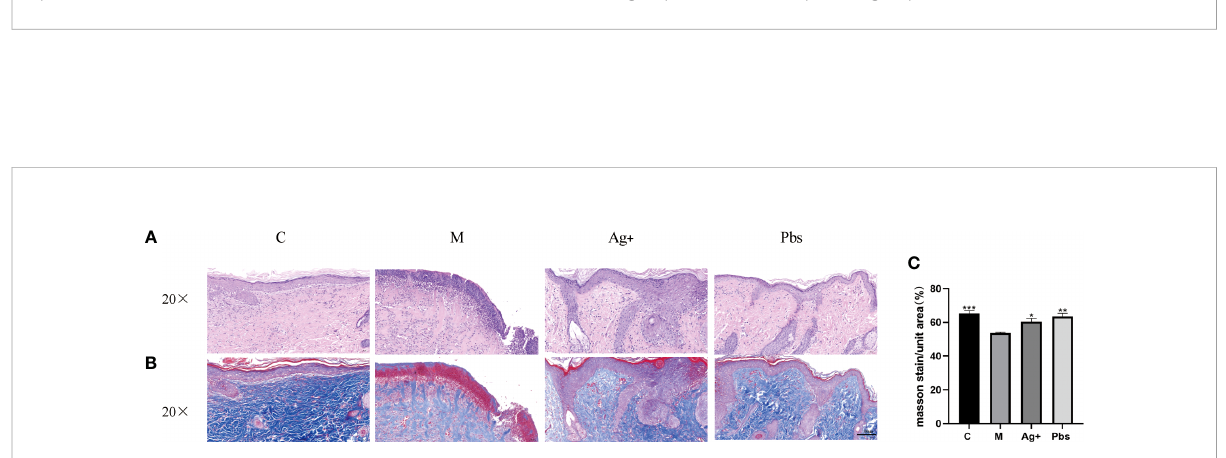
FIGURE 2 Puffball spores improved diabetic foot ulcer recovery in rats. (A) Representative HE staining images of wound tissues, (scale bar = 100 µm; magni fi cation, 200×; n = 3). (B) Representative images of Masson ’ s trichrome (MT) staining, (scale bar = 100 µm; magni fi cation, 200×; the blue color represents collagen; n = 3). (C) Wound tissue collagen fi ber quanti fi cation using Image-Pro Plus. (Means ± SEM, n = 3, *P < 0.05, **P < 0.01, ***P<0.001 vs. model